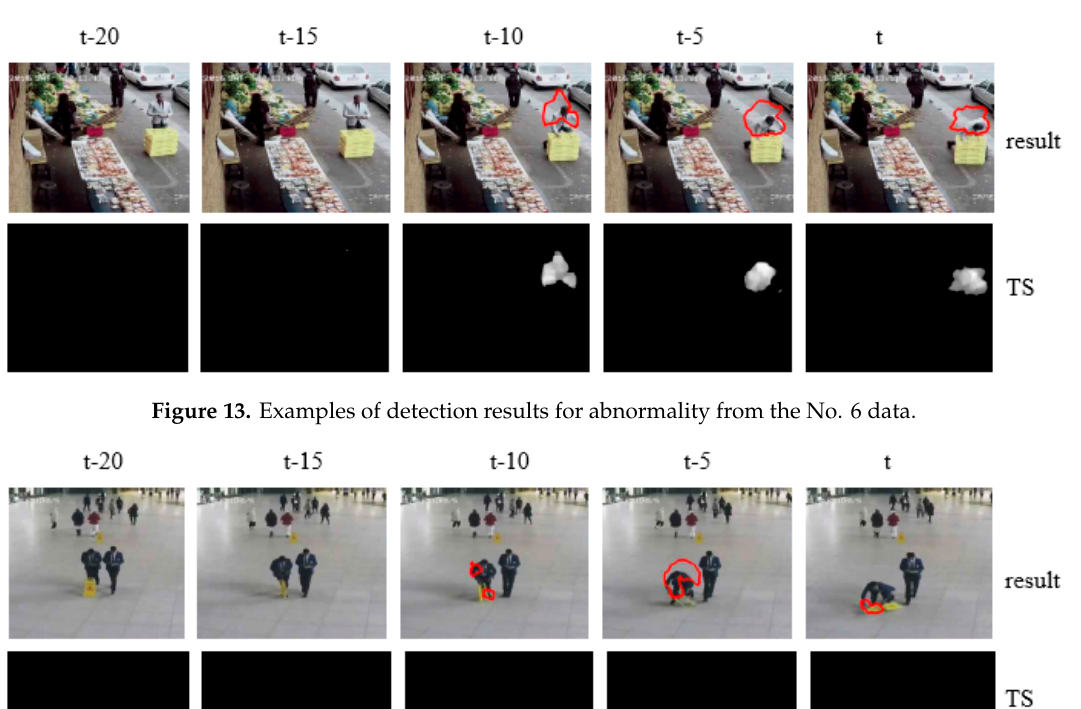
Figure 14. Examples of detection results for abnormality from the No. 7 data.